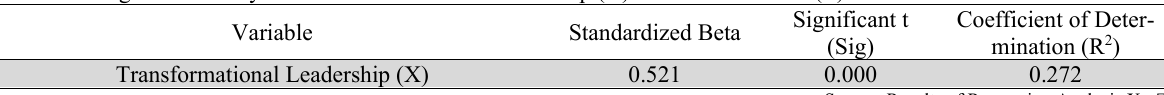
Results of Regression Analysis of Transformational Leadership (X) on Job Motivation (Z) Variable